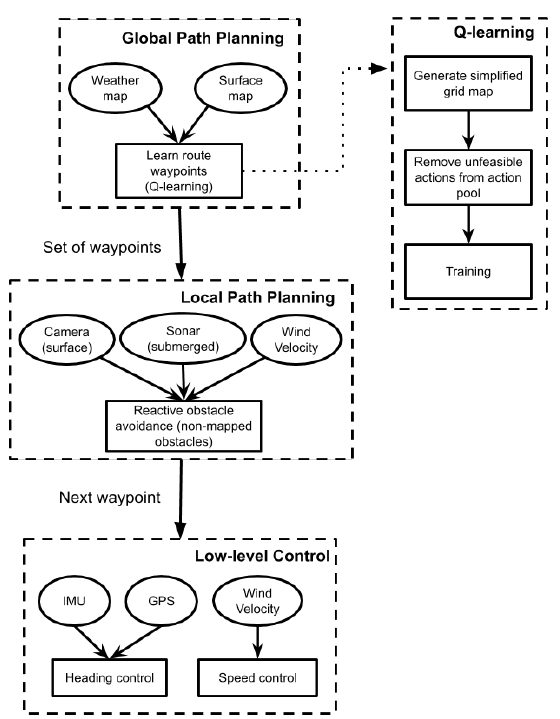
Figure 4. Data flow chart of N-boat